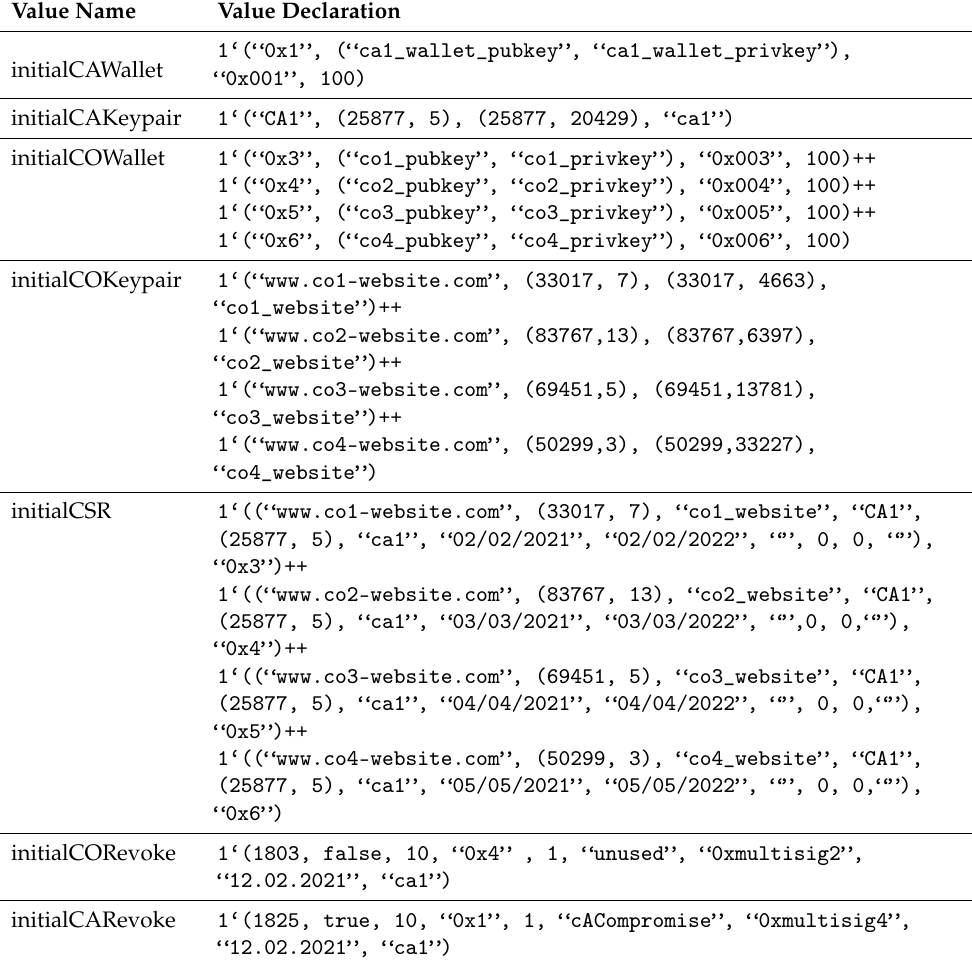
Table 4. Initial markings of the top-level CPN model of